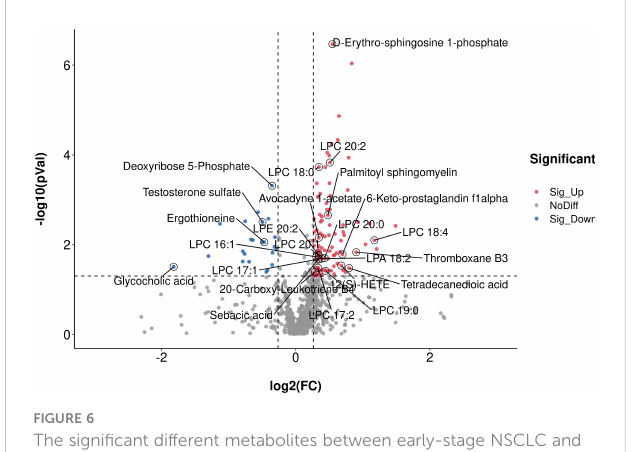
FIGURE 6 The signi fi cant different metabolites between early-stage NSCLC and HC group by Volcano plot Blue dots on the left are metabolites down- regulated in NSCLC vs HC, red dots on the right represent metabolites up-regulated in NSCLC vs HC, grey dots are metabolites that are not signi fi cantly